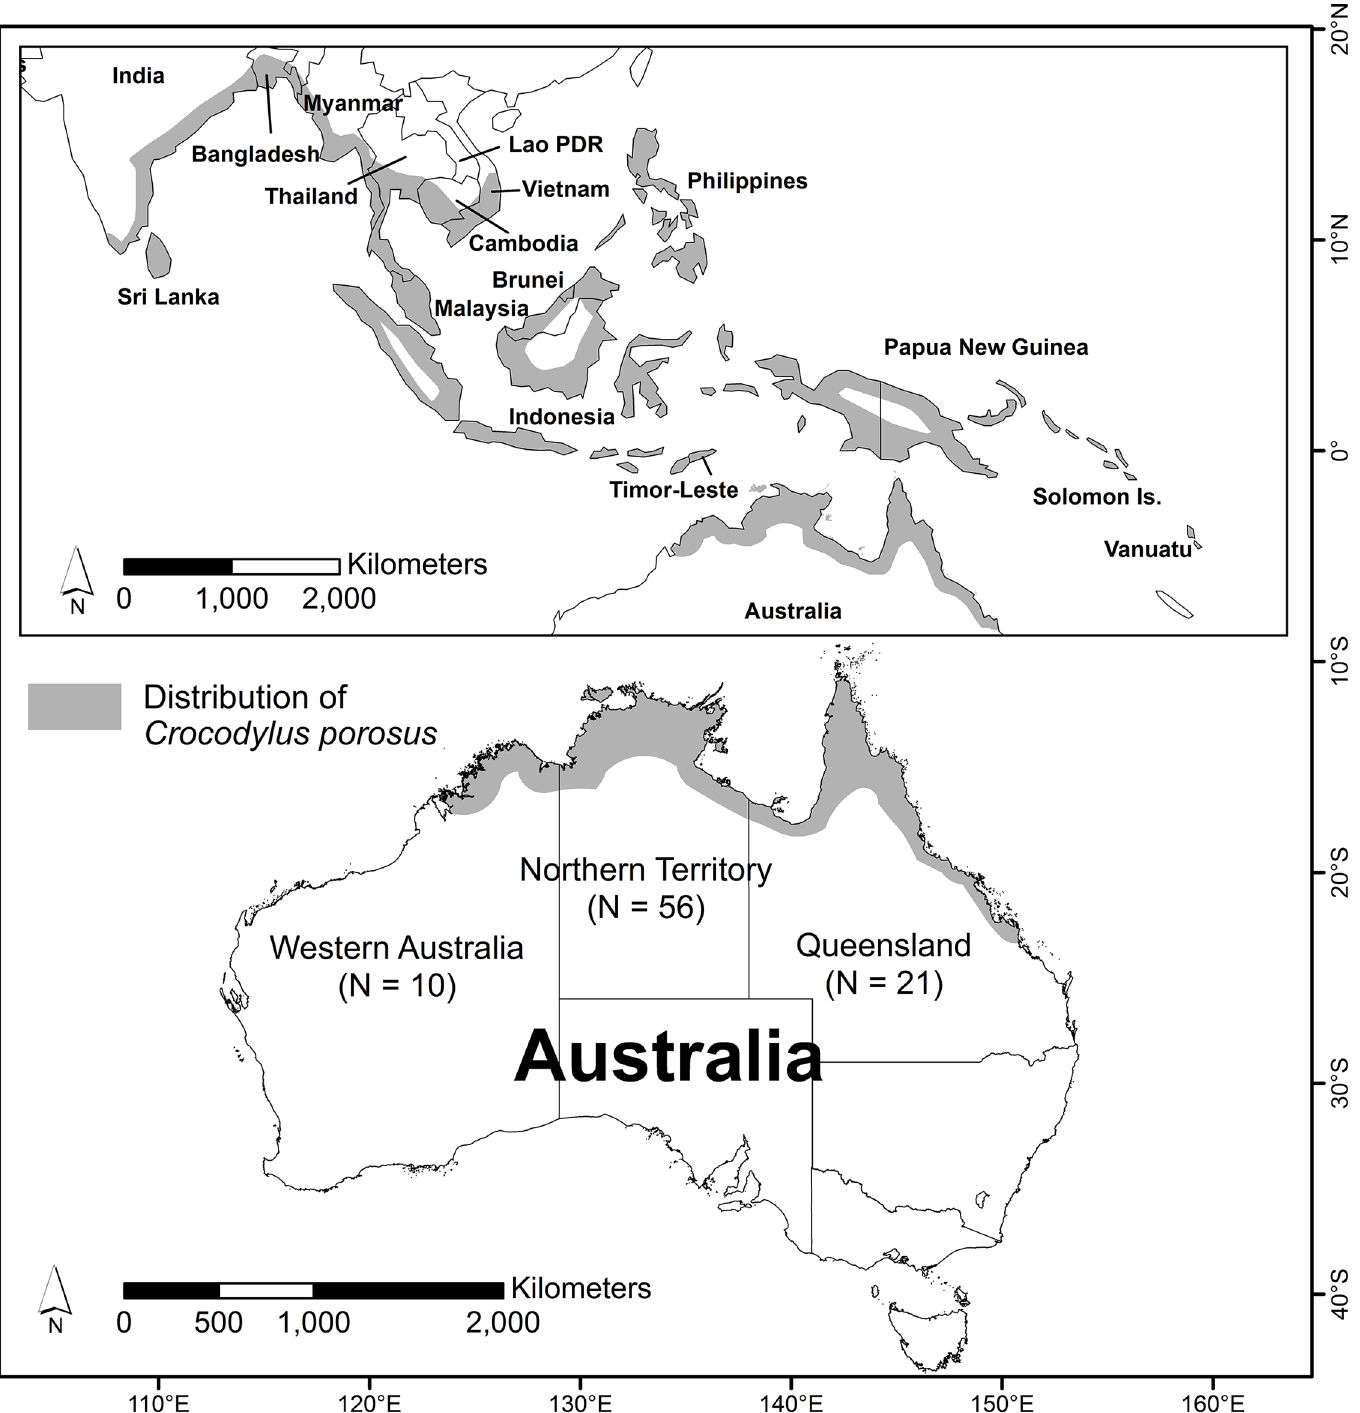
Fig 1. Distribution of Crocodylus porosus in the world and Australia. N is the number of crocodile attacks used in the analysis.